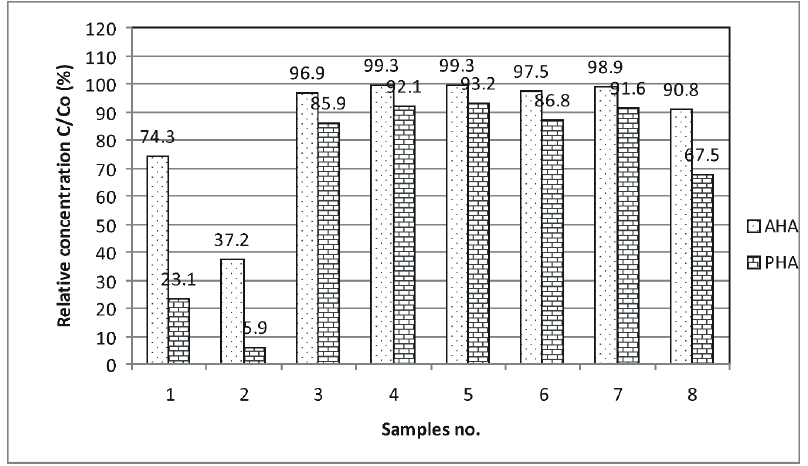
Figure 9. Relative Concentration of immobilized humic acids (AHA and PHA, respectively) as a function of silica support type.